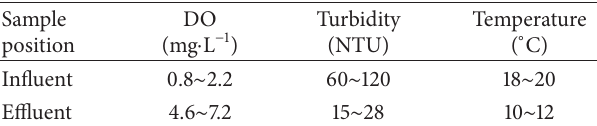
Table 2: Changes of several technical values before and after